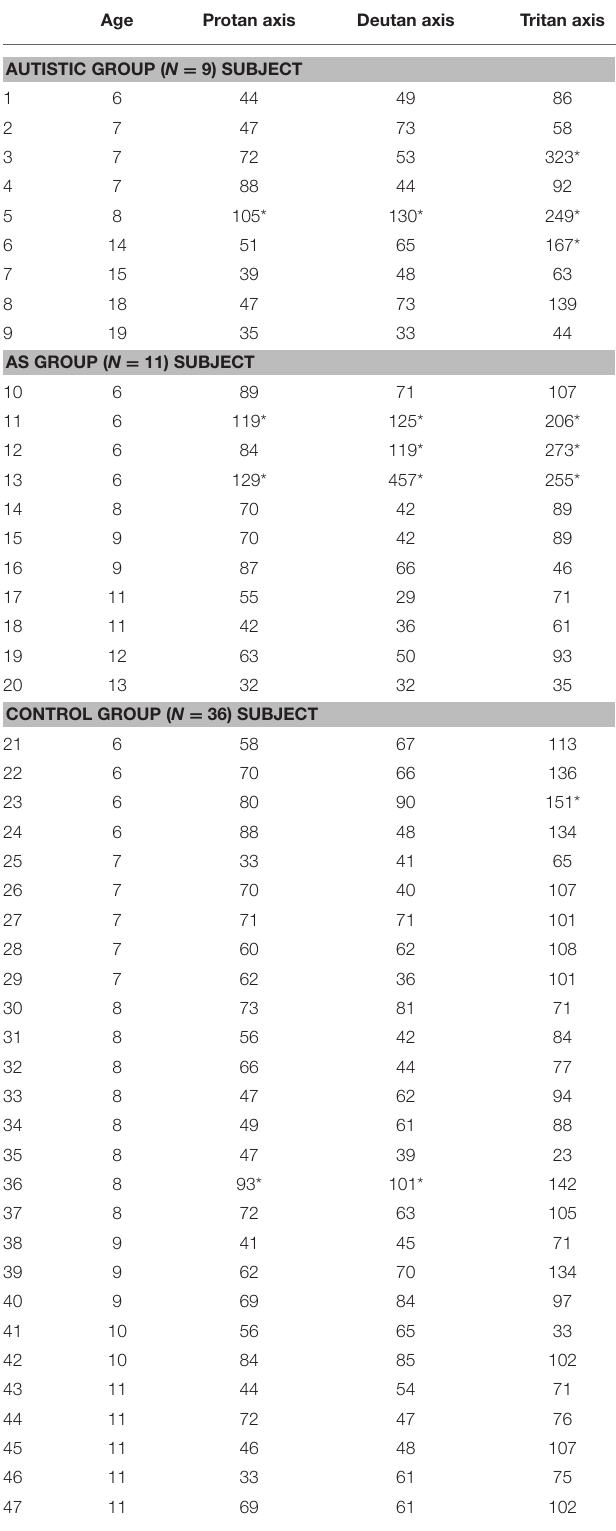
TABLE 3 | Color discrimination thresholds of participants with autism or AS, and controls in u ′ v ′ *10 3 units. Age Protan axis Deutan axis Tritan